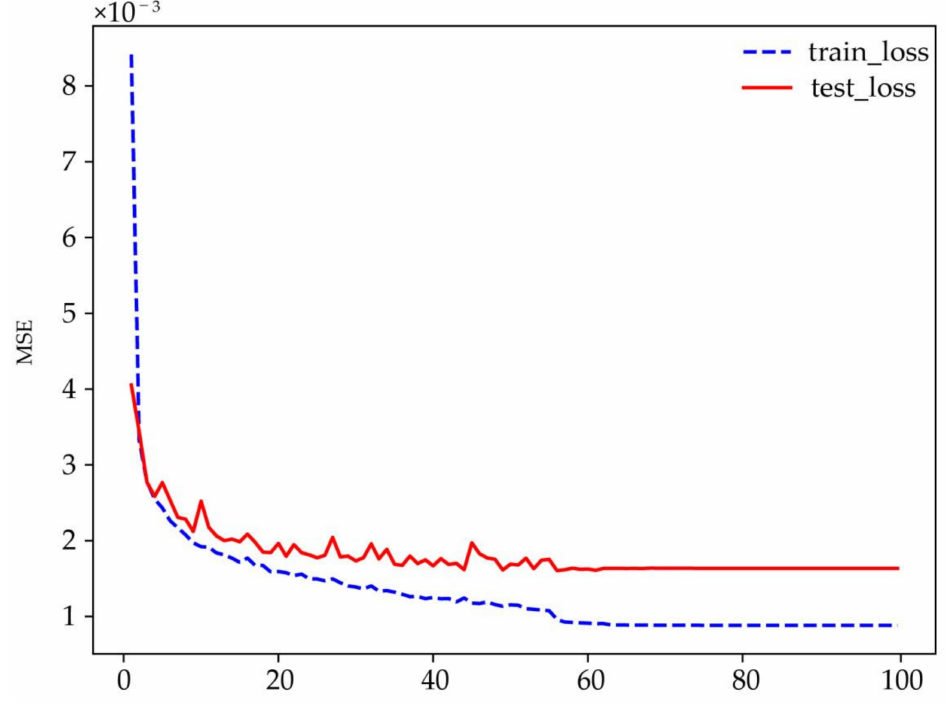
Figure 2. The loss value of training and test dataset per epoch.